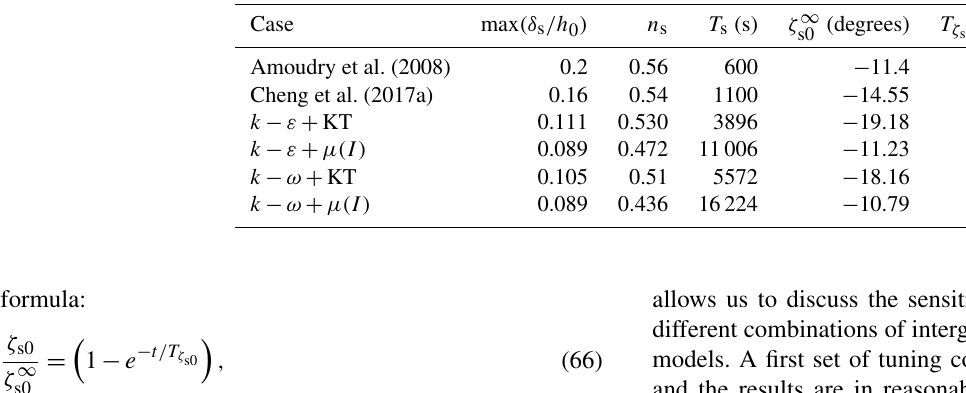
Table 11. Summary of the numerical results obtained for the scour at an apron using the different combinations of turbulence and granular stress models and comparison with existing two-phase numerical results on this